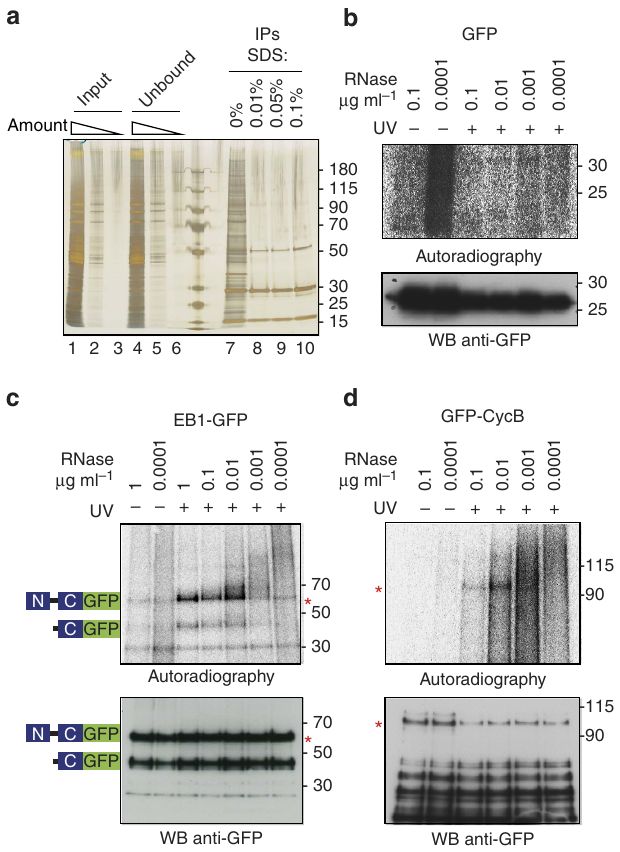
Figure 3 | Validation of CycB and EB1 as RNA-binding proteins. ( a ) Optimization of GFP immunoprecipitation. Protein profiles of total embryo lysates, IPs of free GFP and unbound fractions are visualized on a silver stained polyacrylamide gel. Lanes 1–3: serial dilution of total embryo lysate expressing free GFP; lanes 4–6: serial dilution of unbound fractions after GFP-IP; lanes 7–10: GFP immunoprecipitates washed with buffers containing increasing concentrations (none; 0.01%; 0.05%; 0.1%) of SDS. ( b – d ) Lysates containing free GFP, EB1-GFP and GFP-CycB were treated with various concentrations of RNase A. GFP proteins were IPed from noCL and CL embryos, radioactively labelled, separated on polyacrylamide gels and blotted on PVDF membranes. Upper panels: autoradiography of membranes containing IPs of GFP ( b ), EB1-GFP ( c ) and GFP-CycB ( d ) labelled with g -[ 32 P]-ATP by T4 polynucleotide kinase (see Methods section, PNK assay). Lower panels: visualization of GFP proteins by WB with an anti-GFP